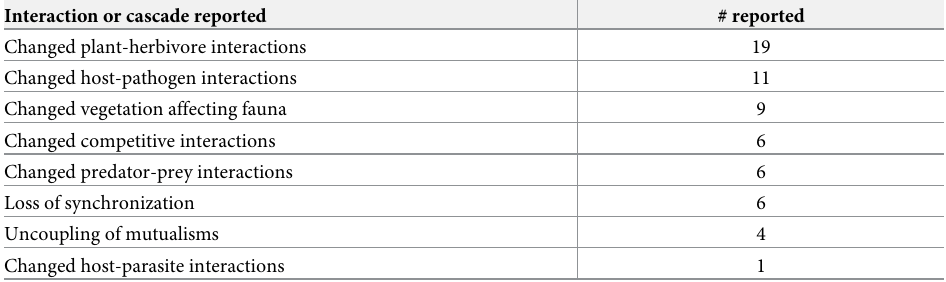
Table 7. Frequency of different types of changes to ecological interactions evident from ecological cascades reported in